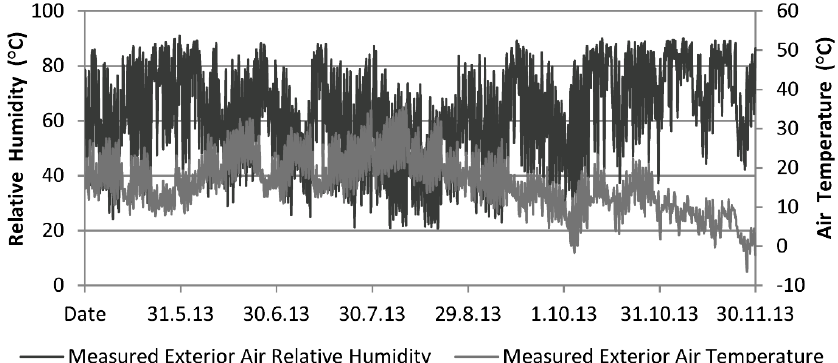
Figure 3. The measured outdoor air temperature in (°C) and the relative humidity of the air (%) for the locality of Košice. Displaying the selected period from May 2013 to December 2013 [28,29].